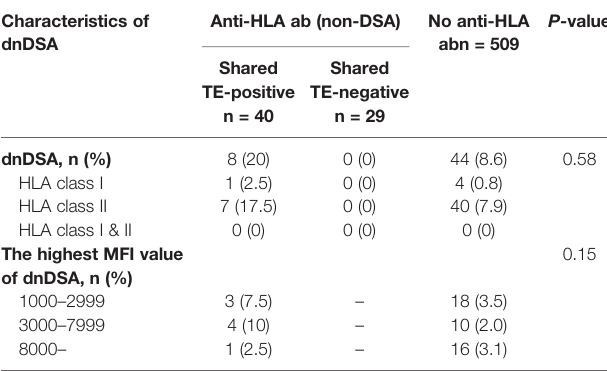
TABLE 3 | Characteristics of dnDSA in 578 patients without preformed DSA during the full observational period. Characteristics of